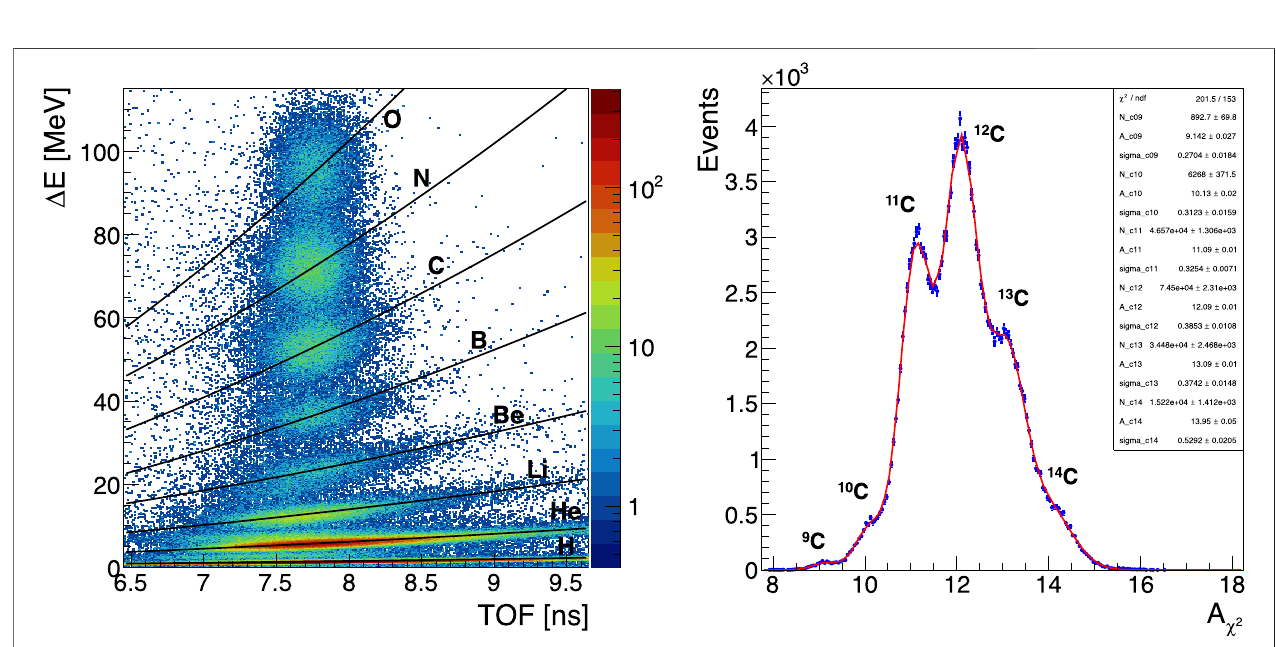
FIGURE 8 | (Left) Fragments charge identi fi cation in TW using the energy release in the scintillators Δ E and the TOF calculation performed together to the SC. For each region a Bethe-Bloch curve (shown as a different black curve), parametrized as a function of TOF, has been used to fi t the MC simulation results to describe the average energy loss of fragments of the same charge Z impinging on TW with different angles, kinetic energies, TOF and path lenghts L . (Right) An example of mass number determination obtained with the χ 2 fi t for the carbon fragments for the case of σ ( TOF ) x 70 ps, σ ( p ) / p x 3 . 7 % and σ ( E kin ) / E kin x 1 . 5 % . The 11 C, 12 C and 13 C isotopes are clearly